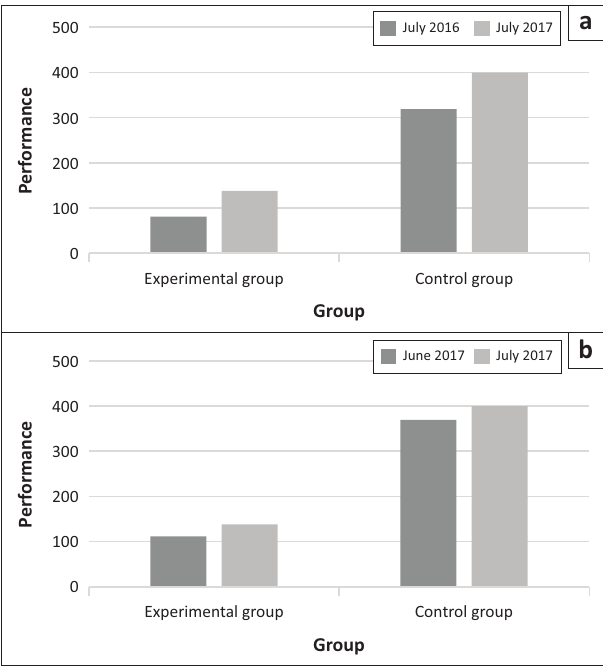
FIGURE 2: Comparison of team performance in the experimental and control groups: (a) July 2016 and July 2017; (b) June 2017 and July